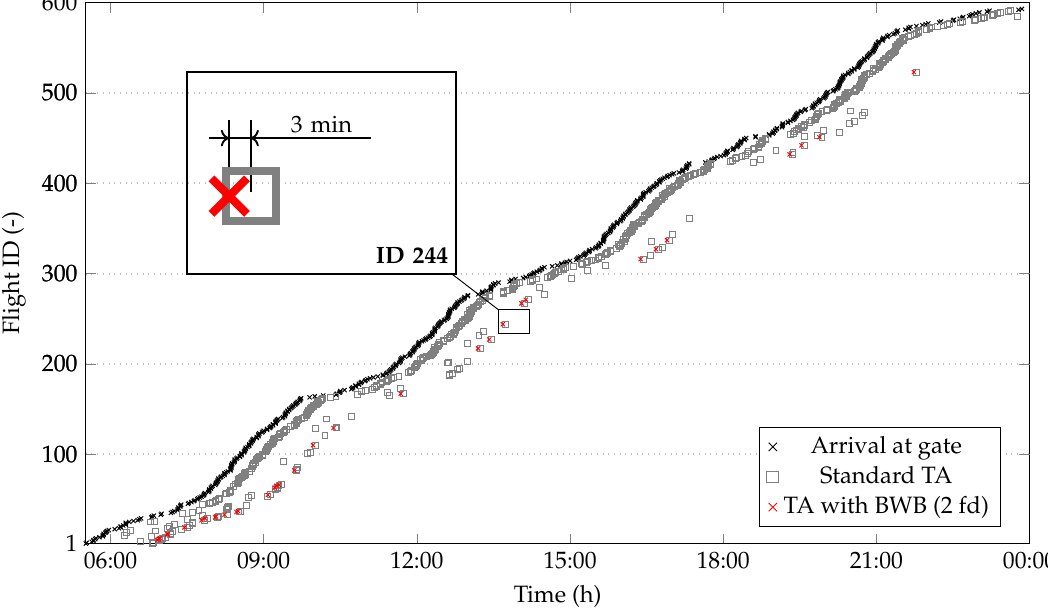
Figure 9. Comparison of turnaround (TA) times with and without the blended wing body